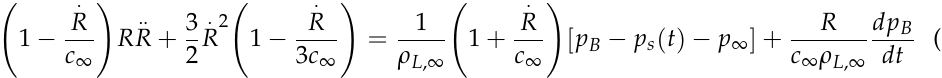
Figure 2. The model of bubble dynamics [22]. Copyright 2004, with the permission from Elsevier. The radius-time curve of a bubble in liquid irradiated with ultrasound is numerically calculated by the Keller equation [5].